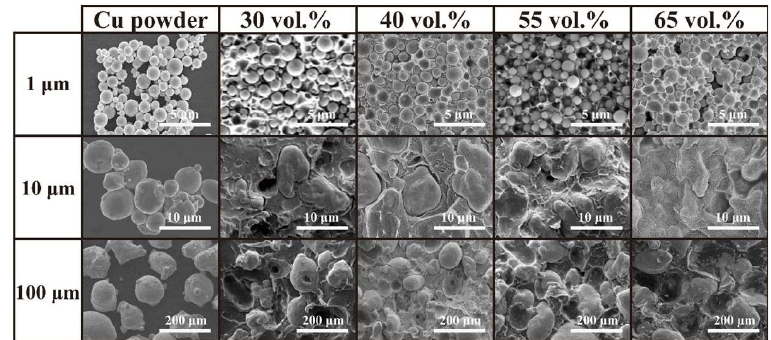
Figure 3. SEM images of Cu Powder and Cu/PMMA composites.